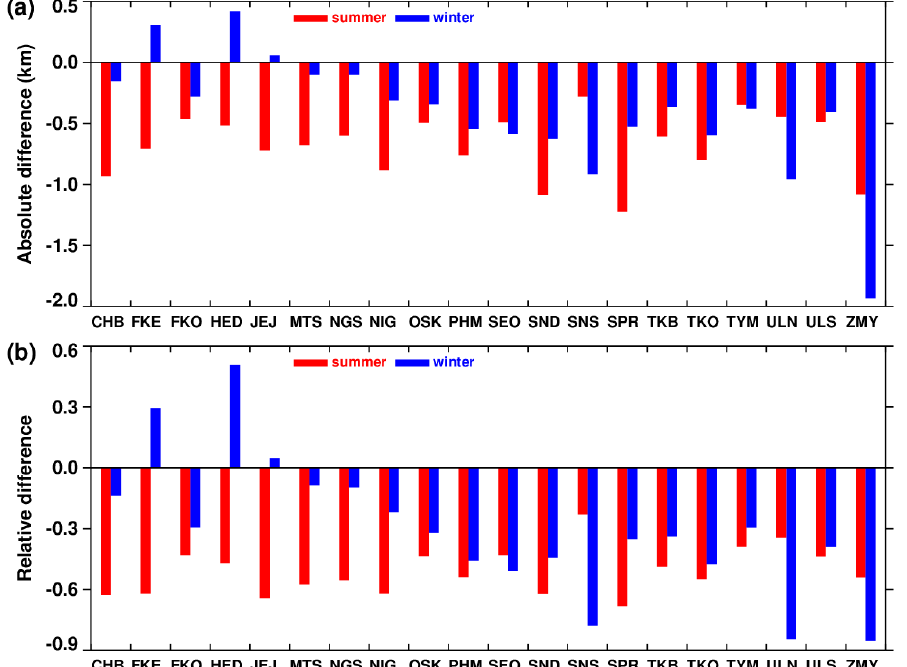
Figure 6. ( a ) Absolute difference, ( b ) relative difference in the BLH from AD-Net and ECMWFs for 20 sites in AD-Net. Table 2. Mean difference in BLH derived from AD-Net and ECMWFs (ECMWFs BLH minus AD- Net BLH) in summer and winter.